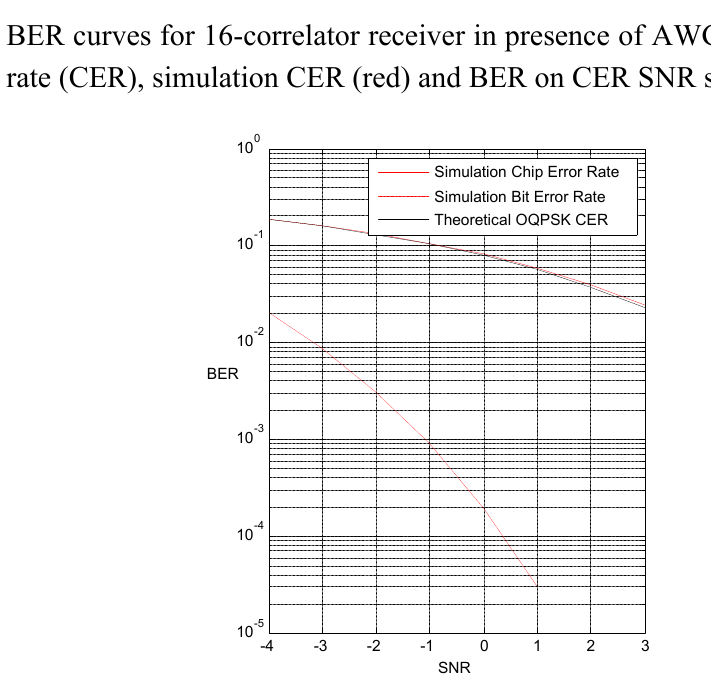
Figure 5. BER curves for 16-correlator receiver in presence of AWGN: theoretical (black) chip error rate (CER), simulation CER (red) and BER on CER SNR scale (red dashed).